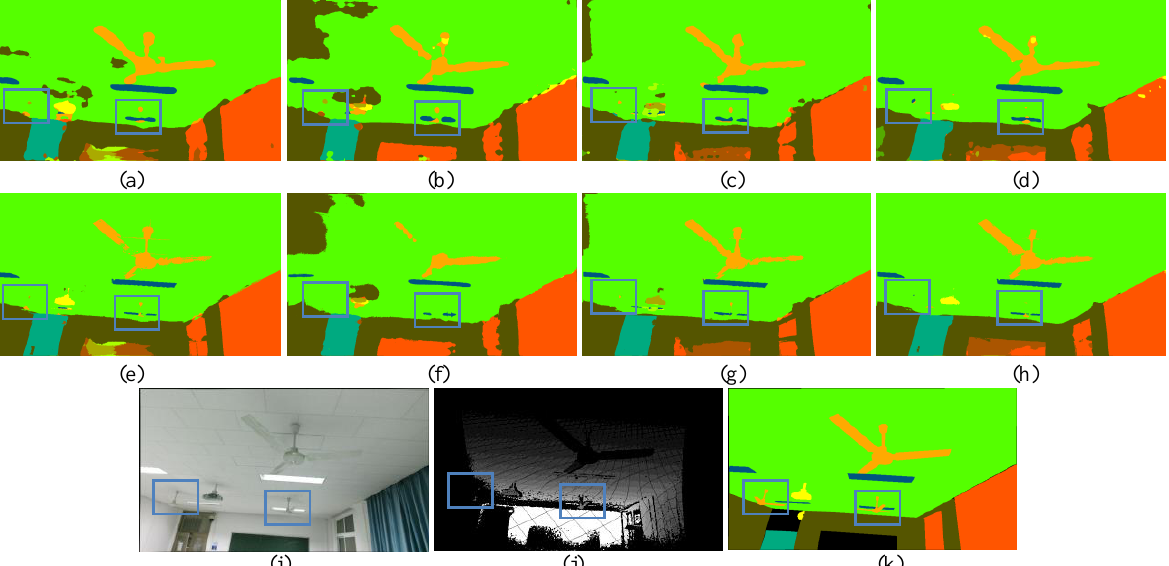
Figure 2. One example of Semantic segmentation results of eight methods. (a) RGB, (b) RGBD, (c) RGBD+MMD1, (d) RGBD+MMD2, (e) RGB+CRF, (f) RGBD+CRF, (g) RGBD+MMD1+CRF, (h) RGBD+MMD2+CRF, (i) RGB image, (j) Depth image, (k) Ground